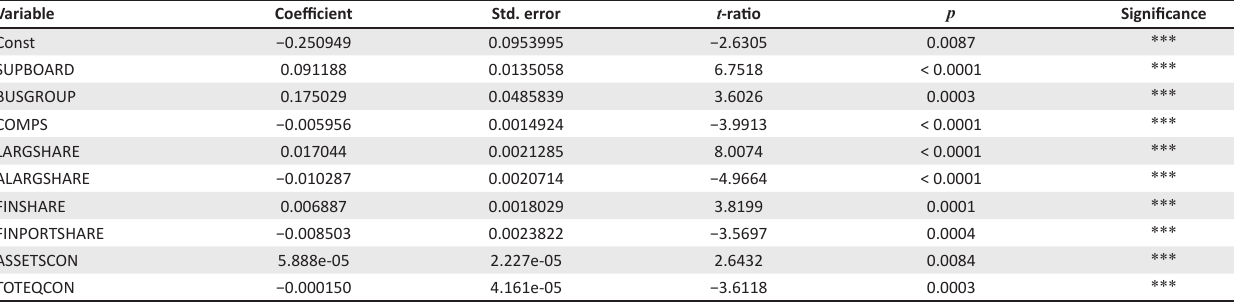
TABLE 5: Model tabulations for dependent variable: PYRAMID. Variable